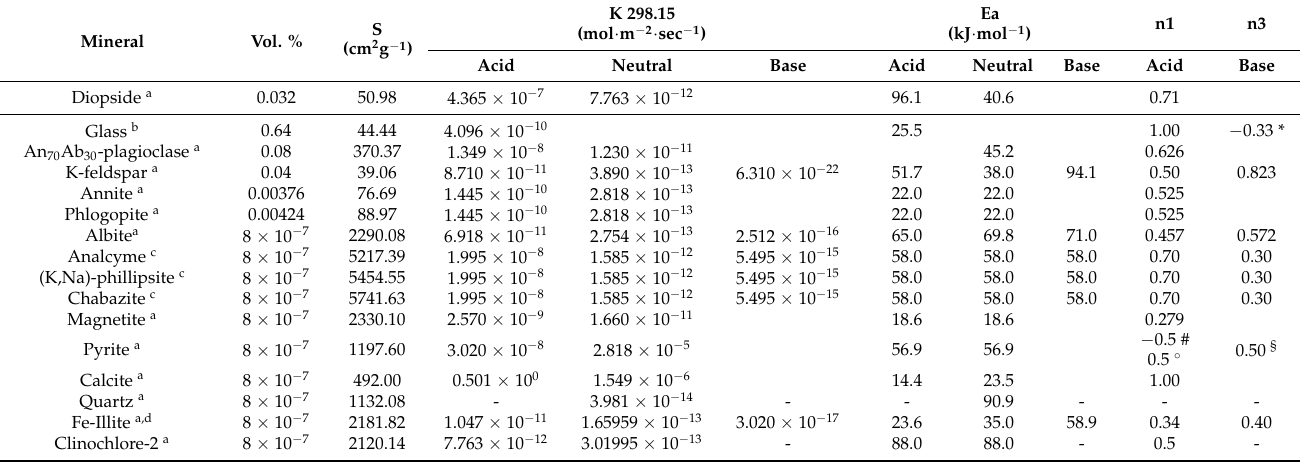
Table 7. Kinetic parameters for Equation (2) of the considered